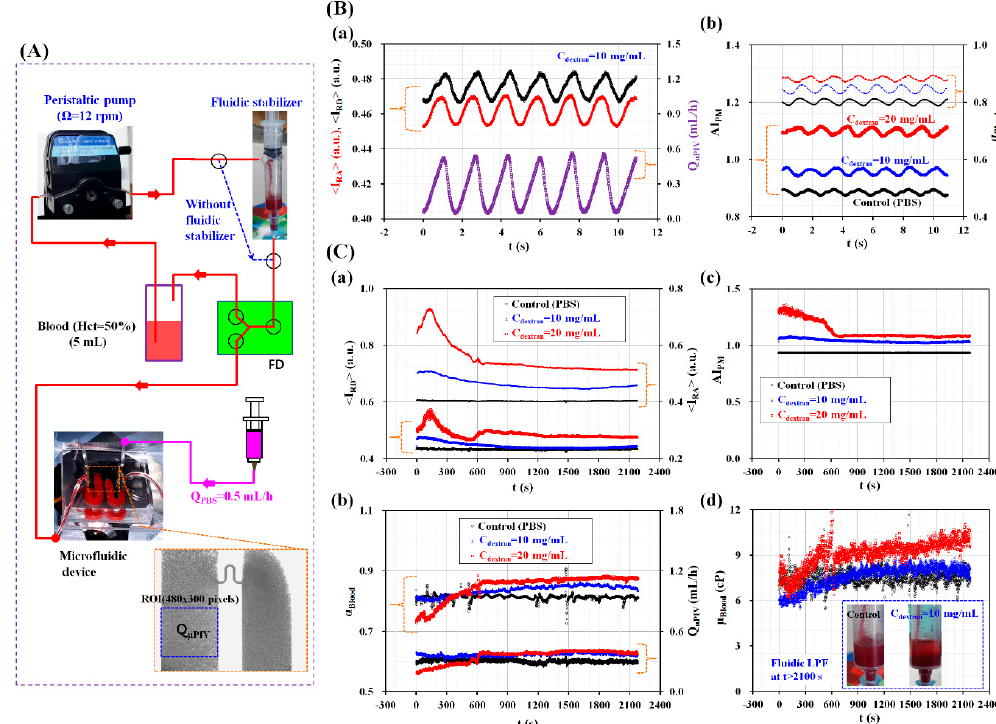
Figure 6. Continuous and simultaneous measurement of RBC aggregation and blood viscosity of blood circulating within an in vitro closed fluidic circuit. ( A ) Schematic diagram of the fluidic circuit constructed by connecting several components such as a peristaltic pump, a fluidic stabilizer, fluid divider (FD), a microfluidic device and reservoir, and a syringe pump. ( B ) Quantitative evaluation of RBC aggregation index and blood-filled width depending on various concentrations of dextran solution, under periodic blood flow conditions. (a) Temporal variations of <I RA >, <I RD >, and Q µ PIV for blood (RBCs suspended in dextran solution (C dextran = 10 mg/mL)). (b) Temporal variations of AI PM and α Blood with respect to C dextran (C dextran = 0 mg/mL, 10 mg/mL, and 20 mg/mL). ( C ) Quantitative evaluation of RBC aggregation index (AI PM ) and blood viscosity (µ Blood ) with respect to C dextran , especially in constant blood flow. Since the fluidic stabilizer removed pulsatile blood flows, blood flow remained constant in the microfluidic device. (a) Temporal variations of <I RD > and <I RA > with respect to C dextran . (b) Temporal variations of AI PM with respect to C dextran . (c) Temporal variations of α Blood with respect to C dextran . (d) Temporal variations of µ Blood with respect to C dextran . Inset shows RBC sedimentation in the fluidic stabilizer depending on base solutions (PBS solution, and dextran solution (C dextran = 10 mg/mL)) after 2100 s were elapsed.